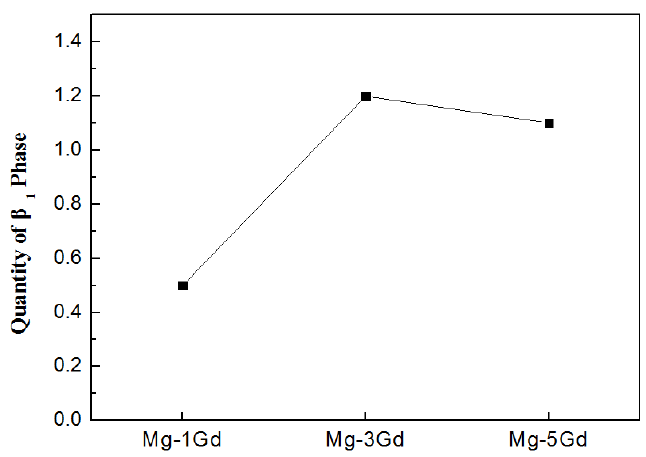
Figure 10. The quantity of the (Mg,Zn) 3 RE phase in the as-cast Mg-xGd alloys based on the XRD pattern.